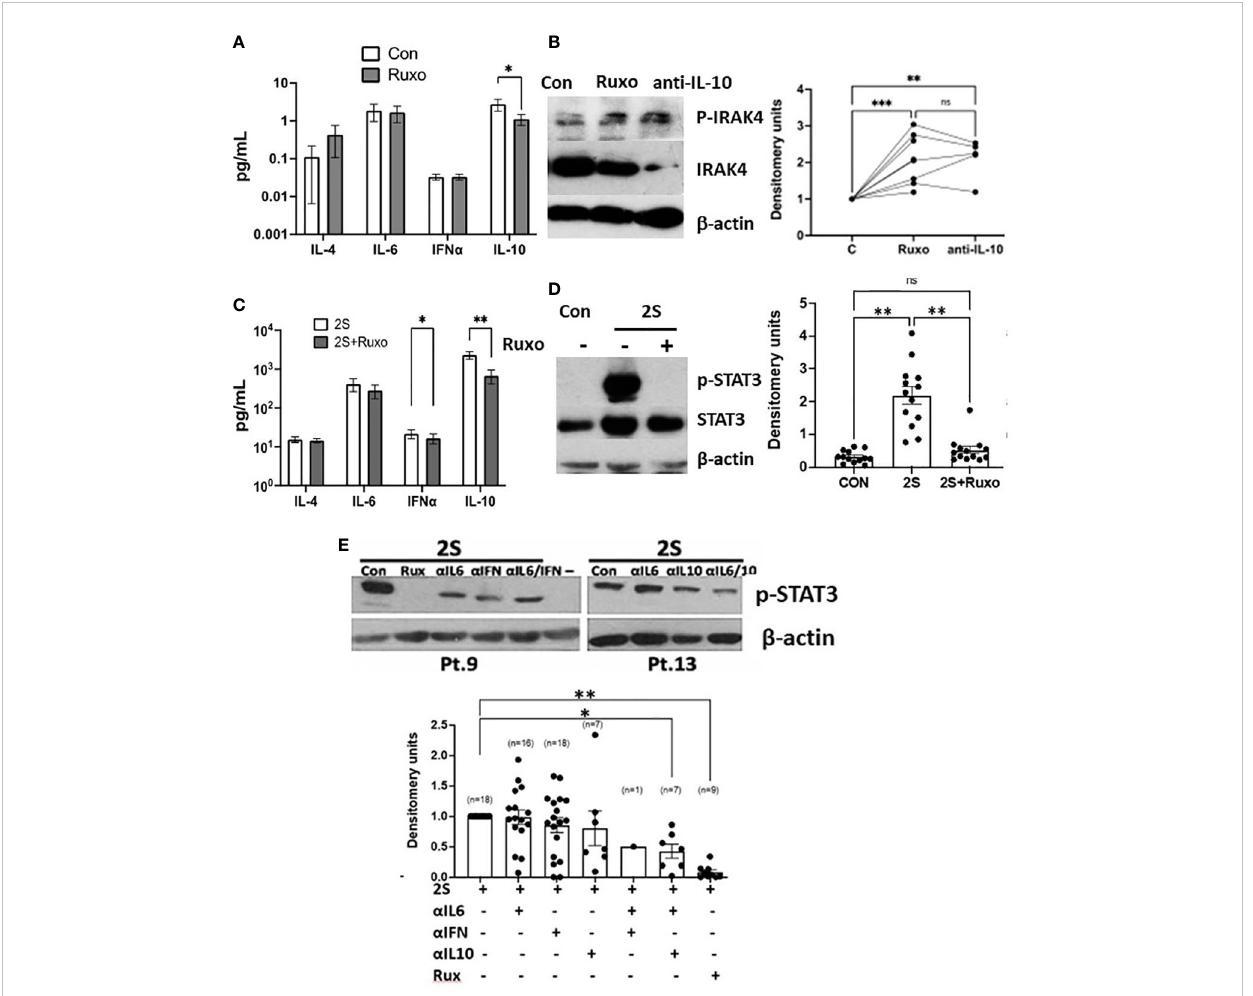
FIGURE 2 Divergent IRAK4 and STAT3 activity in ruxolitinib-treated CLL cells in vitro . CLL cells were cultured in AIM-V with (2S) or without (Con) IL-2 (500 U/ ml) and resiquimod (1 m g/ml) and with or without ruxolitinib (Ruxo) (500 nM) or combinations of antibodies against IL-10, the IL-6 receptor, and the type 1 IFN receptor (all at 10 ng/ml). (A, C) Cytokines were measured in culture supernatants after 48 h from 13 (A) and 19 (C) individual patient samples. (B, D, E) After 18 h, phospho-IRAK4 (B) and -STAT3 (C, D) were measured by immunoblotting and densitometry and normalized to b